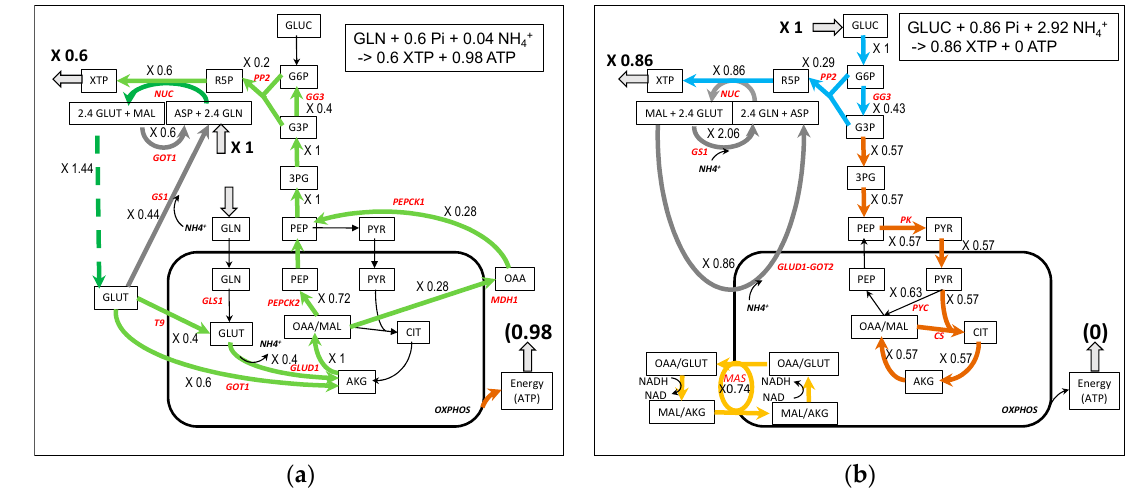
Figure 5. A simplified representation of nucleotides synthesis from glutamine ( a ) and glucose ( b ). Note that in ( b ), the flux through T4 and GOT 2 can be split, in the malate–aspartate shuttle (MAS) with a flux of 0.74 and in a 0.86 flux corresponding to aspartate recycling. The complete model is in Figures S5a and S5b in the Supplementary Materials.